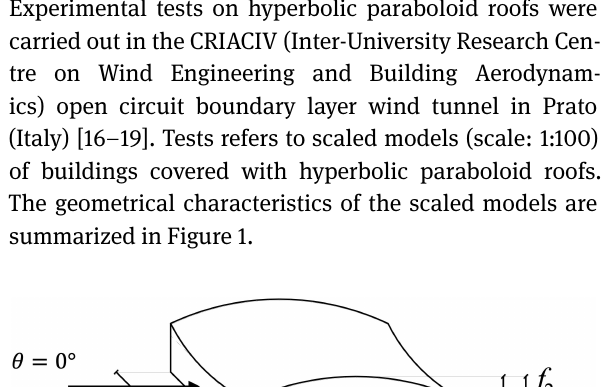
Tests were performed considering ( i ) four different plan shape (square, rectangular, circular, and elliptical plan) ( ii ) two different curvatures (low and high), and ( iii ) four different total heights. Sixteen different geometries were investigated. The tests were repeated for sixteen wind